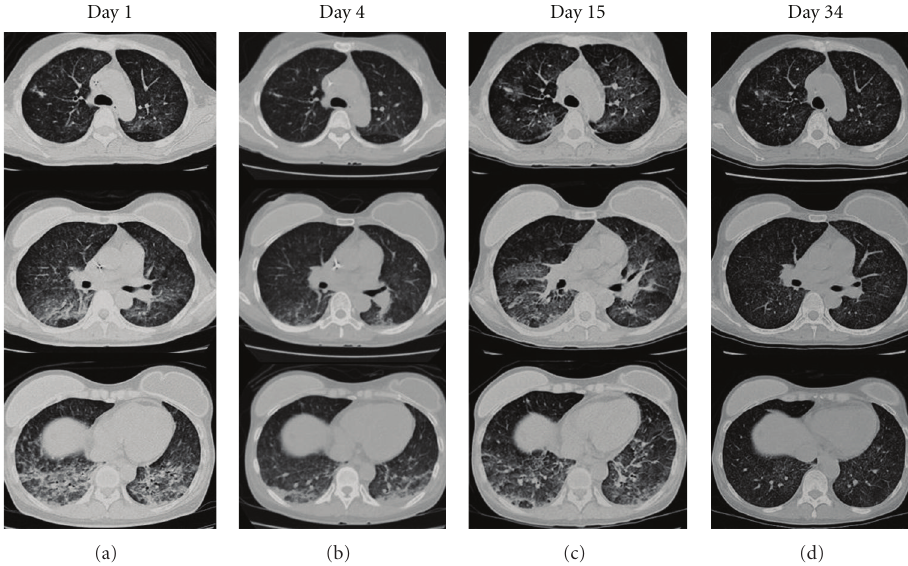
Figure 1: CT findings. (a) On admission, nodular and macular shadows in the right upper and intermediate lobes and left inferior lobe and ground-glass opacities in both inferior lobes were seen. (b) On day 4, interstitial opacity improved. (c) On day 15, interstitial opacity was worsened. (d) On day 34, miliary nodules were seen in both lung fields, but interstitial shadows were ameliorated.